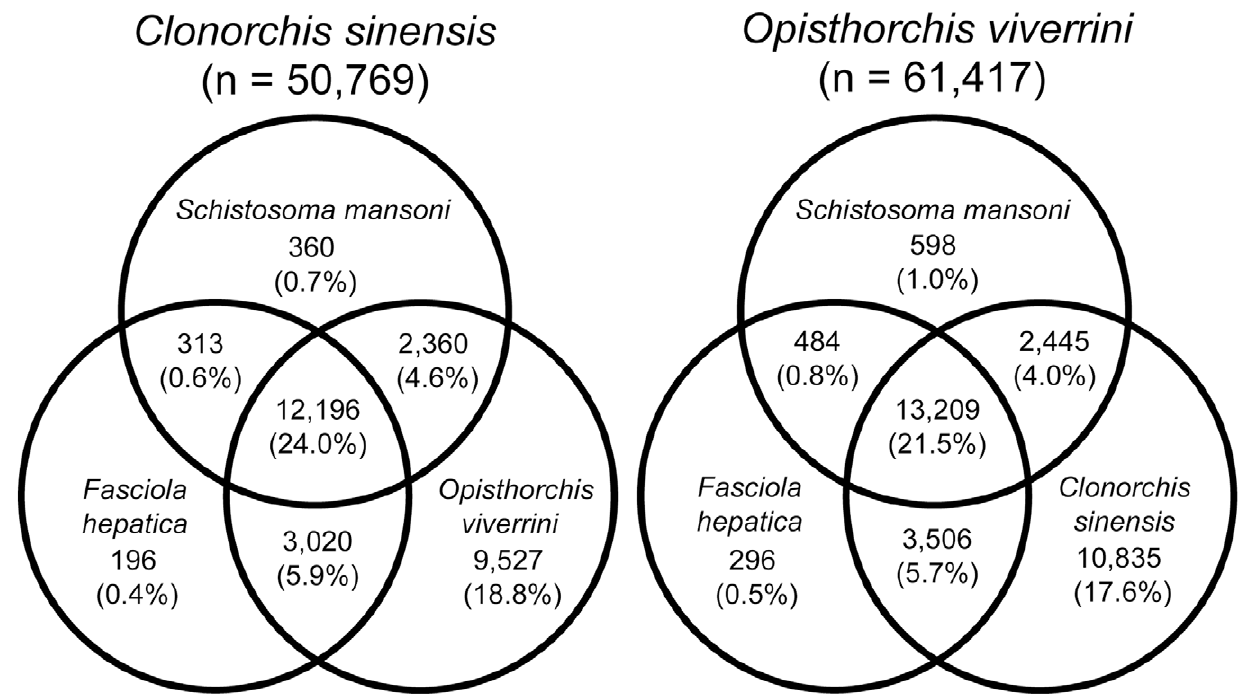
Figure 1. Venn diagram illustrating the overlap in sequence homology among parasitic trematodes. Predicted proteins with significant sequence similarity (permissive BLASTx search with E-value , 1E 2 05 ) among parasitic trematodes, Clonorchis sinensis and Opisthorchis viverrini (family Opisthorchiidae), Schistosoma mansoni (Schistosomatidae) and Fasciola hepatica (Fasciolidae).